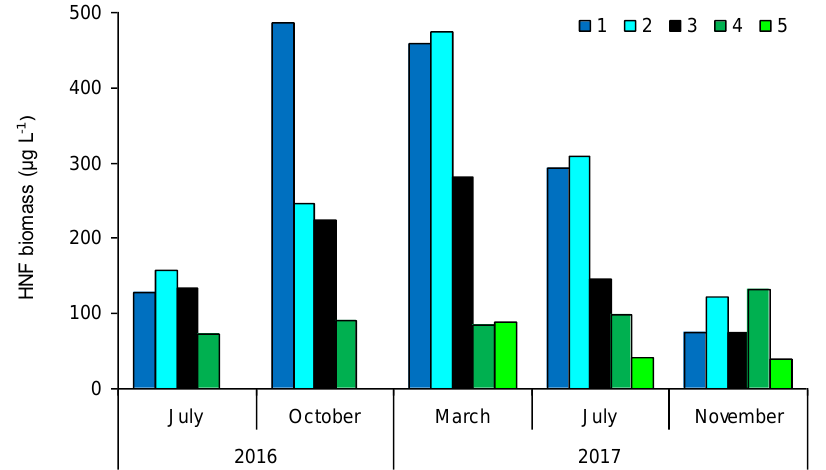
Figure 4. Temporal and spatial distribution of heterotrophic nanoflagellate (HNF) biomass; sites 1–4 in Lake Warnołty, site 5 in Lake Śniardwy.